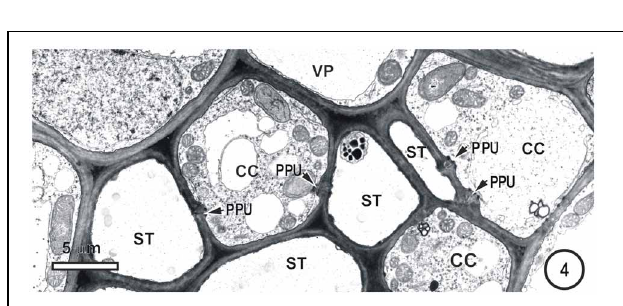
FIGURE 6 | Aspects of anatomy and cell associations in a transverse section through part of an intermediate vascular bundle (left) from a mature Panicum maximum leaf blade, cut at the level of an emerging transverse vein sieve tube (ST, to right). Based on its position, this is also thin-walled. Two TST (arrowheads) and several ST are visible in the longitudinal bundle.